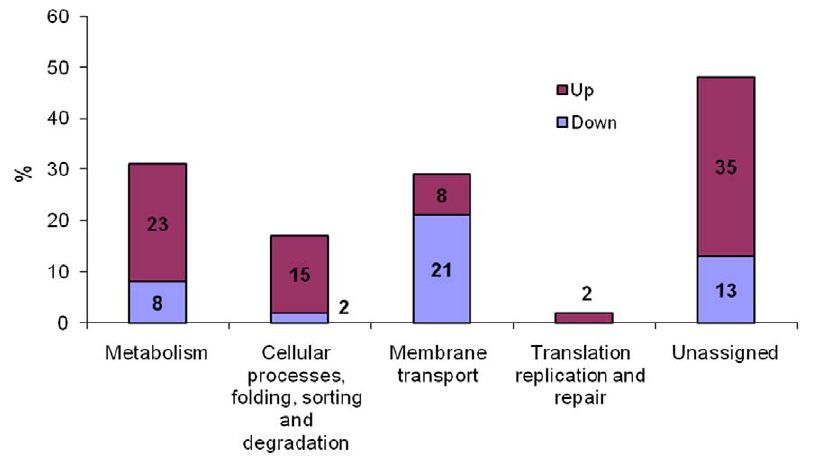
Figure 1. Distribution in functional categories of genes differentially expressed in bvrR mutant compared to parental strain. Unassigned group included eighteen genes with not pathway categories and thirty genes encoding for hypothetical proteins.